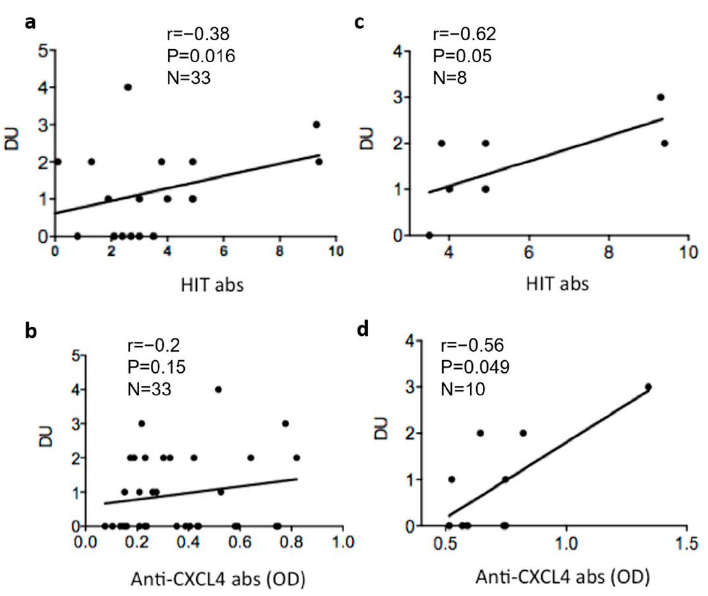
Figure 5. Heparin-dependent (HIT) antibodies correlate with digital ulcers. Numbers of digital ulcers (DU) was plotted against values of HIT ( a , c ) antibodies or anti-CXCL4 ( b , d ) antibody response (expressed as OD). Spearman’s correlation test was used to address correlation between these antibody types and DU. The “r” coefficient of correlation, p (significance) and N (sample size) are reported on the graphs. In the right-hand graphs only patients with positivity for the antibodies are